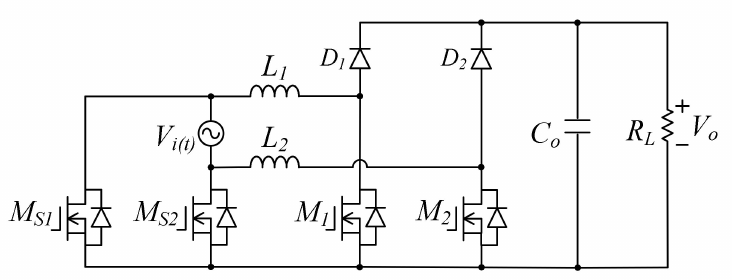
Figure 4. Schematic diagram of the modified bridgeless boost converter with low CM noise for PFC